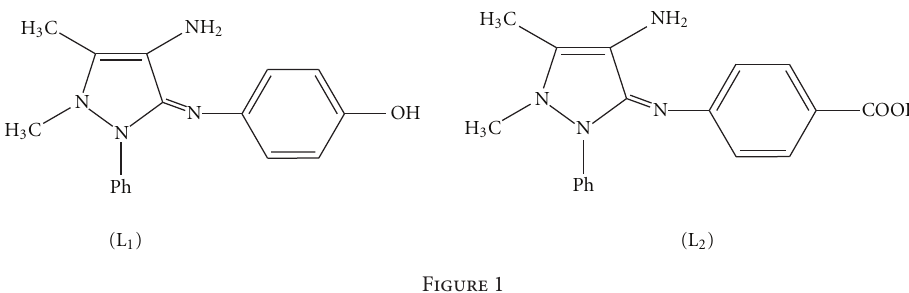
T 1: ermodynamic functions for the dissociation of ligand